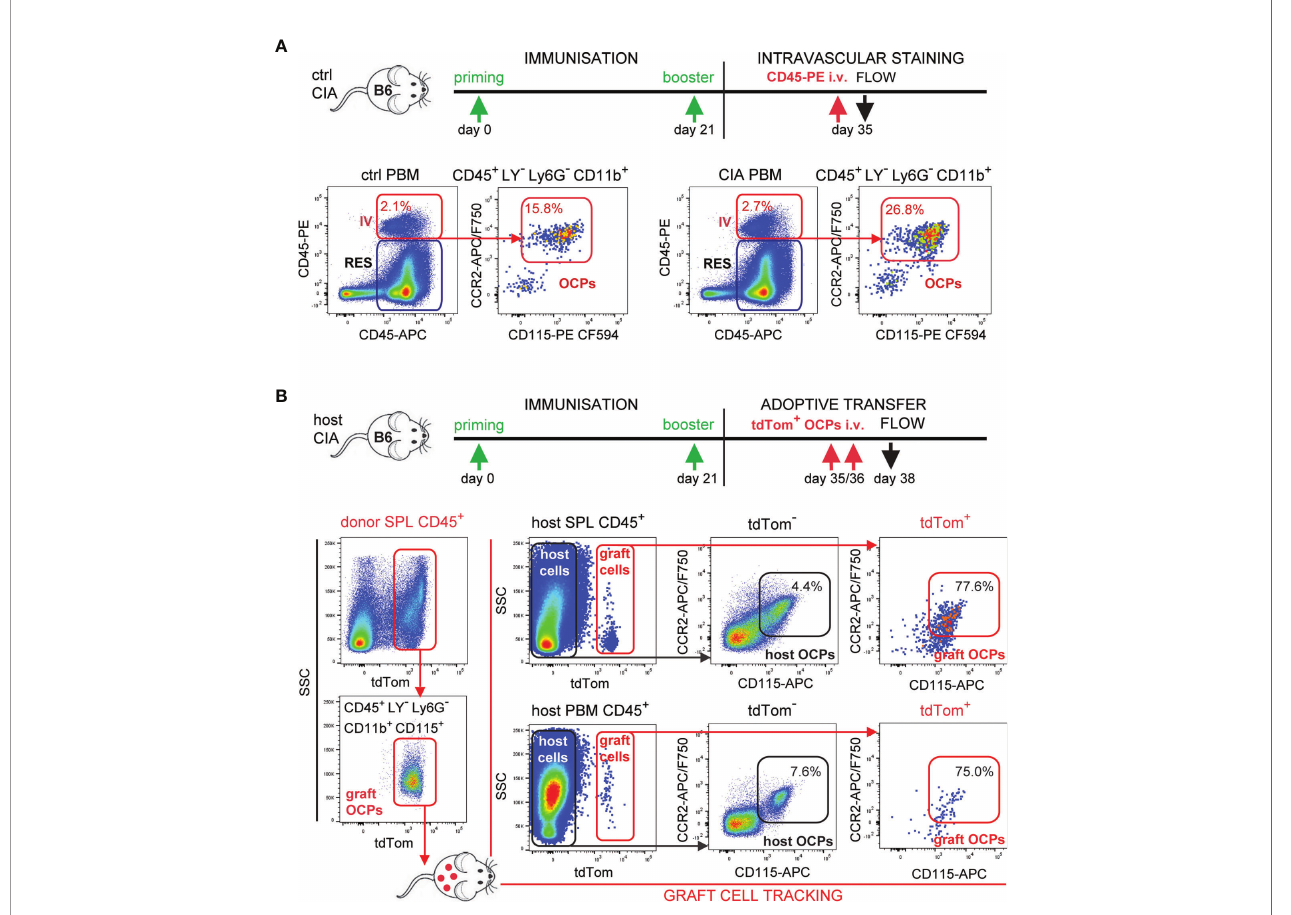
FIGURE 6 | Tracking of the migration and homing of circulatory osteoclast progenitors (OCPs) to the affected sites in B6 mice with collagen-induced arthritis (CIA). (A) Experimental timeline for CIA model and intravascular (IV) staining in B6 mice. Increased recirculation of OCPs (CD45 + CD3 – B220 - NK1.1 - Ly6G - CD11b + CD115 + ) from arthritic mice (CIA) in comparison to control (ctrl). Hematopoietic blood cells were stained in vivo by intravenous (i.v.) anti-CD45 fl uorescent (PE) antibody. Mice were sacri fi ced and harvested periarticular bone marrow (PBM) was stained ex vivo by anti-CD45 fl uorescent (APC) antibody. Double-positive cells represent the intravascular compartment (PE + APC + IV), whereas single-positive cells represent the resident compartment (PE – APC + RES) within PBM. Representative dot plots and cell frequencies for ctrl and CIA are shown. (B) Experimental timeline for CIA model and adoptive transfer in B6 mice. Adoptive transfer of sorted tdTomato-positive spleen (SPL) OCPs (CD45 + CD3 - B220 - NK1.1 - Ly6G - CD11b + CD115 + ) from LysMcre/Ai9 mice to the host B6 mice with arthritis was performed (total 0.5×10 6 cells/ mouse i.v.). Representative dot plots of sorting ef fi ciency for tdTomato + graft OCPs are shown on the left. Frequencies of host (tdTomato - ) and graft (tdTomato + ) OCPs (CD45 + CD115 + CCR2 + ) in SPL and PBM are presented on the right. LY —